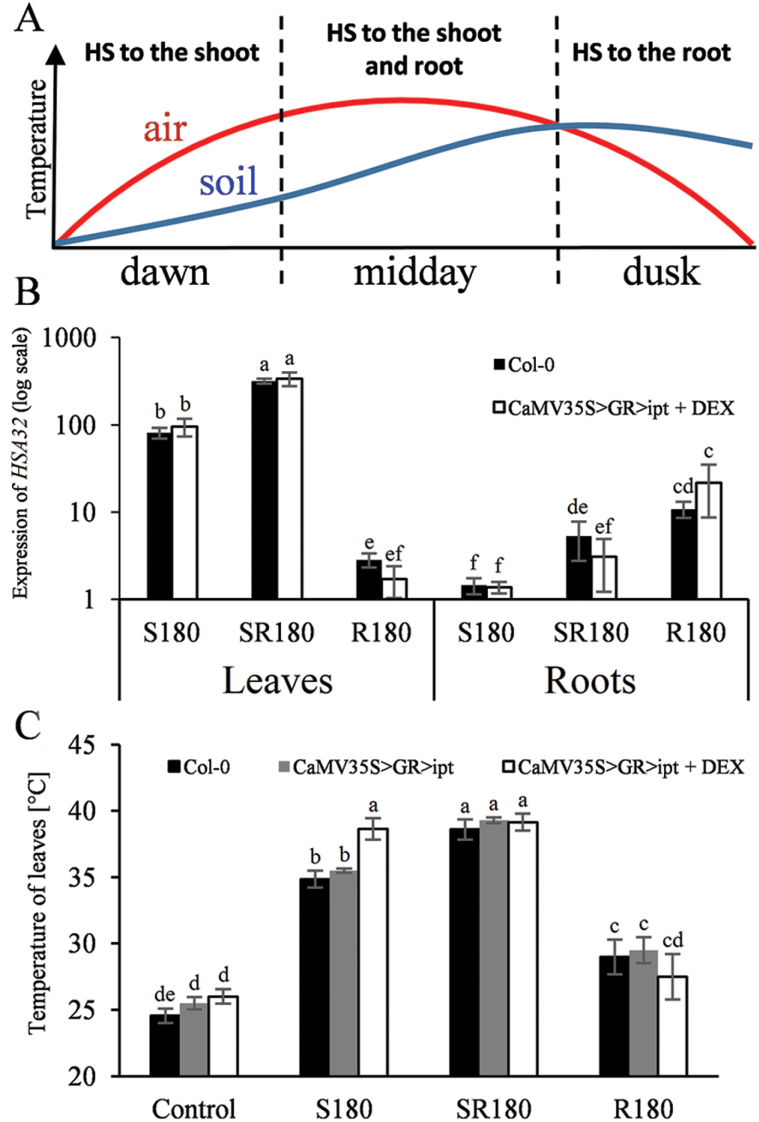
(A) Time course of air and soil temperature profile during a summer day in nature. (B) Transcript levels of heat stress marker gene HSA32 in leaves and roots. (C) Leaf temperature of wild-type (Col 0), non-induced, and DEX-induced ipt transformant after prolonged HS exposure. HS (40 °C) treatment was applied to the shoots (S), whole plant (SR) or roots (R). HS duration was 180min. Unstressed organs were held at 20 °C. Transcript results represent mean values±SD from three independent biological replicates with three technical replicates for each. Leaf temperature data represent means±SD (n≥50). Statistical differences are indicated by letters.